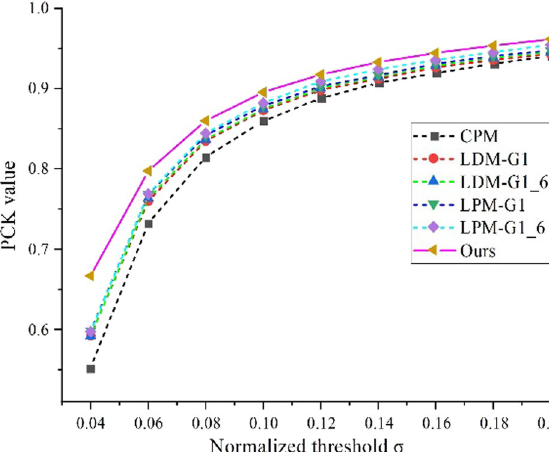
Fig. 10 PCK curve of different